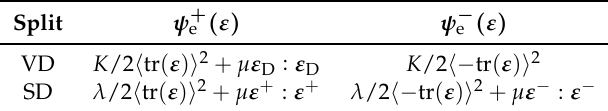
Table 1. Strain energy decompositions: volumetric-deviatoric split (VD) and spectral decomposition (SD), where K stands for the bulk modulus and λ , µ for Lame’s coefficients. ε D is the deviatoric part of (cid:1) = (cid:0) a + the strain tensor. The Macaulay brackets are defined as /2, and the positive/negative a a | | (cid:104) (cid:105) p i p i follow from the principal strains ε i and the dyadic products of the ε i components ε ± = ∑ i ±(cid:104)± (cid:105) ⊗ eigenvectors p i of ε . Split ψ + e ( ε ) ψ − e ( ε